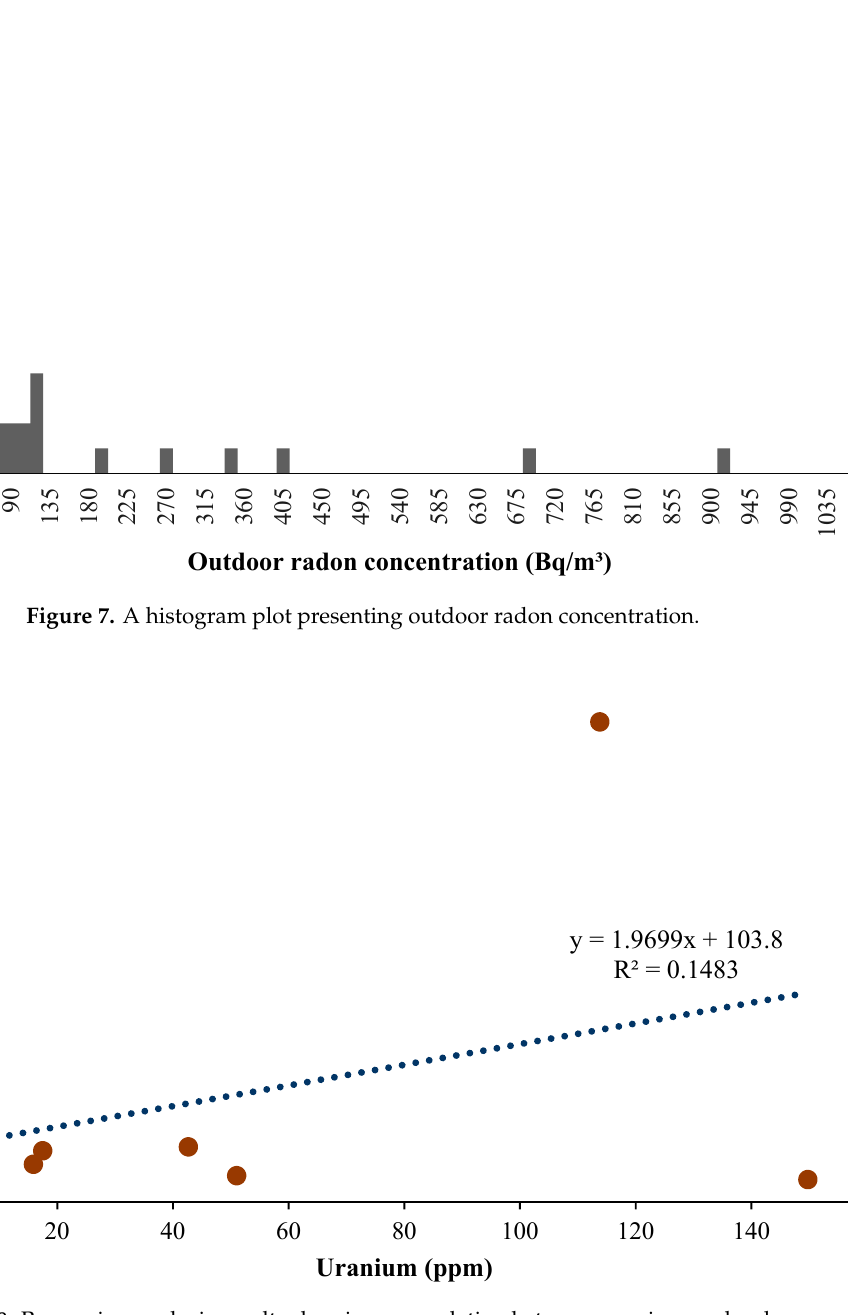
Figure 8. Regression analysis results showing a correlation between uranium and radon .